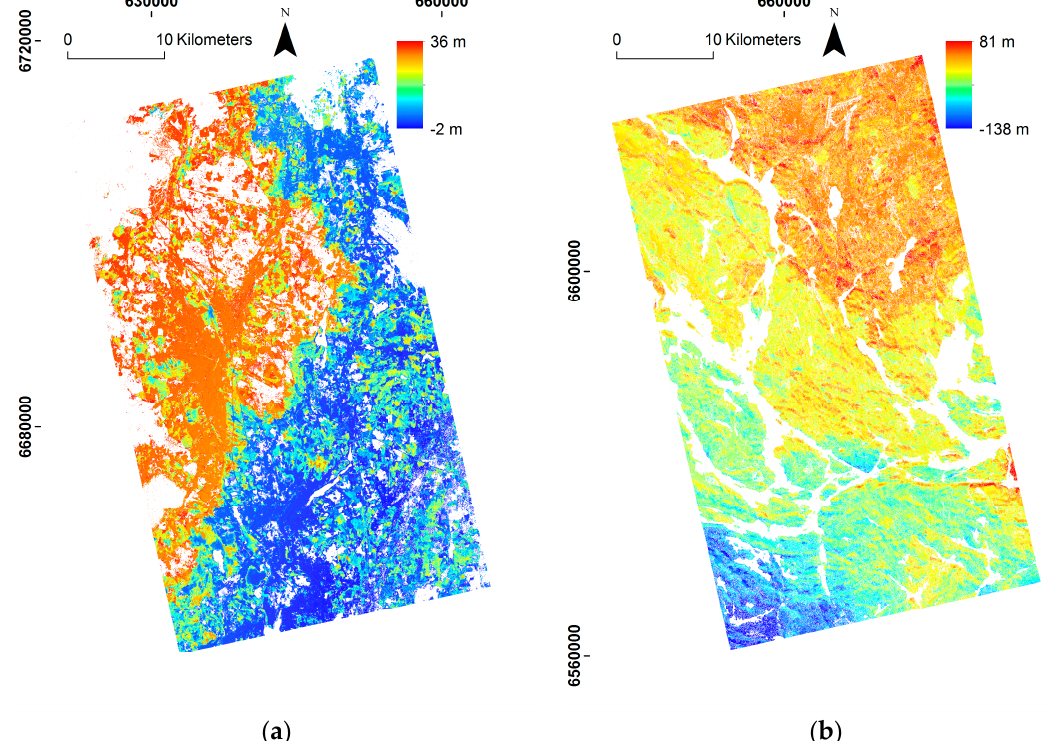
Figure 8. Two examples of falsely-unwrapped phase heights, with ( a ) half of the image having been assigned entirely wrong heights, as these phases (or the cost of unwrapping them) exceeded the allowed range [- π , π ], normally constraining heights to lie within the valid height of ambiguity (HOA), and ( b ) in addition to large regions being wrongly unwrapped, also large spots of incorrect heights are interspersed within the wrong regions, e.g., the red spots within the yellow central region possess heights that are at least HOA m larger than the yellow heights.